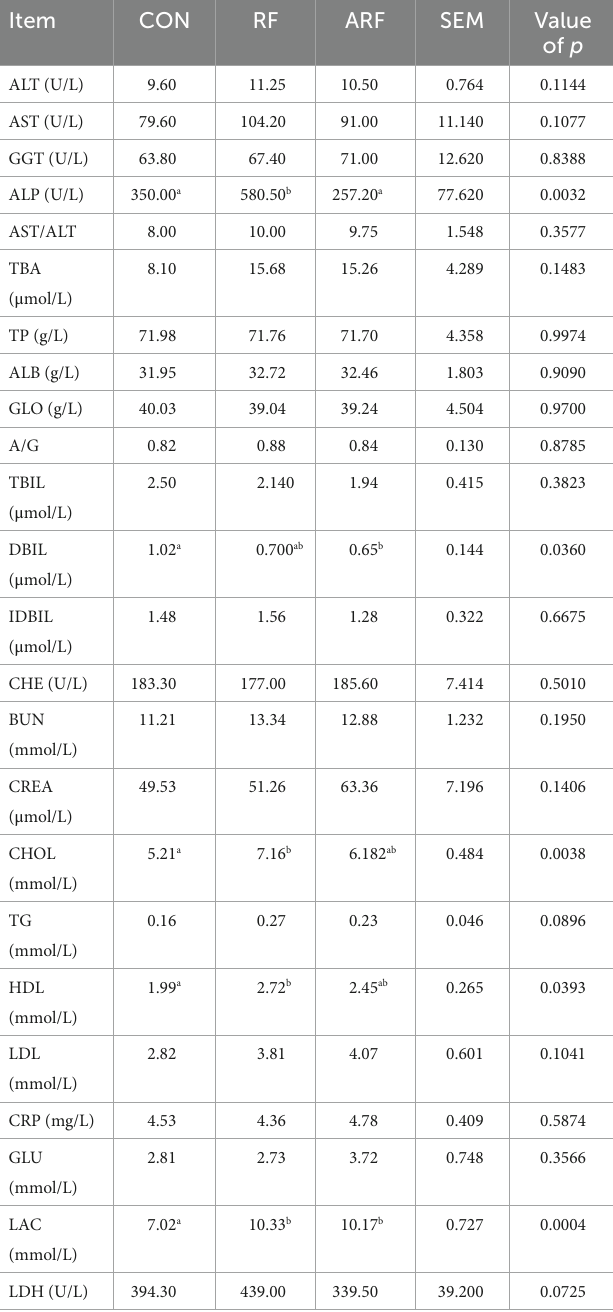
TABLE 1 Effect of inoculation with ruminal fluid (RF), autoclaved ruminal fluid (ARF) or sterilized physiological saline (CON) on blood biochemical indices in